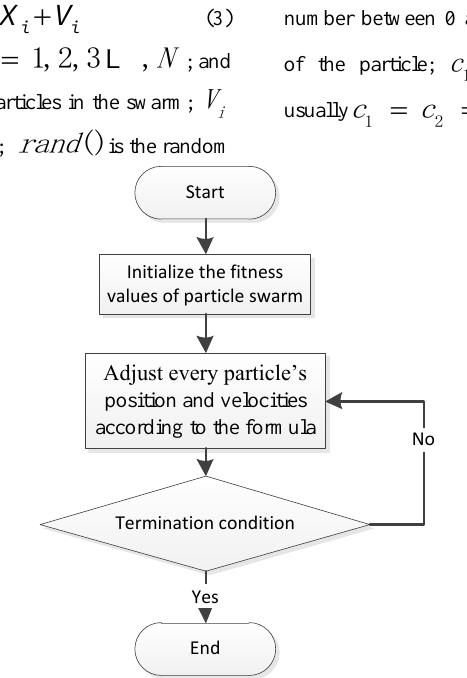
Figure 2 The flow chart of Particle Swarm Optimization algorithm